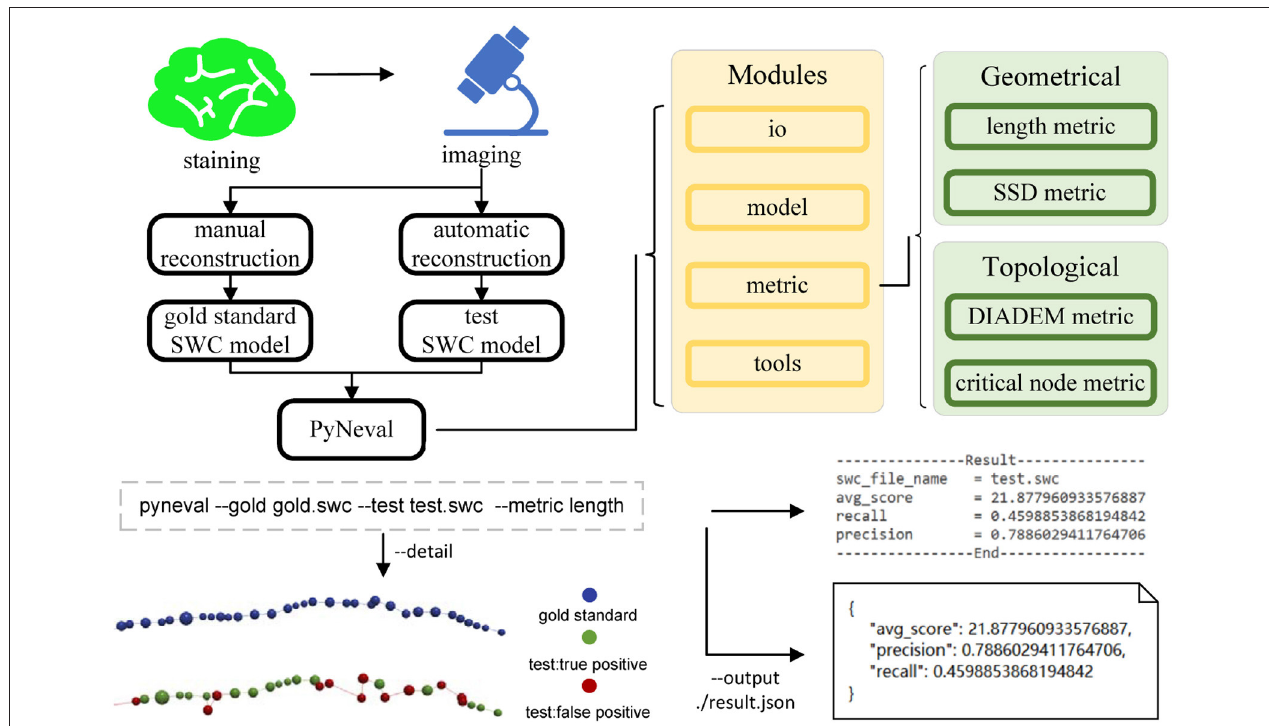
FIGURE 1 | The overview of PyNeval, which can take a gold standard model and a test model from the same image as input through a command line interface and outputs quality scores of the test model, as well as more details about reconstruction errors. Four different metrics, including the length and substantial spatial distance (SSD) metrics in the geometrical category and the DIADEM and critical node (CN) metrics in the topological category, are available in PyNeval.